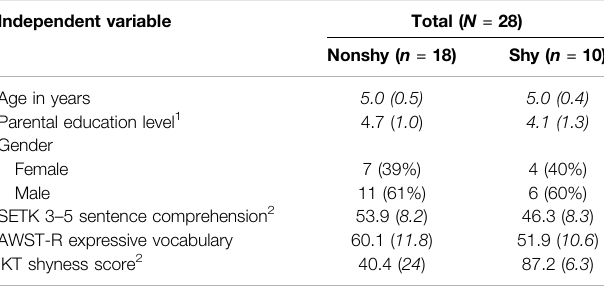
TABLE 1 | Mean participant characteristics for shy and nonshy children and standard deviation (SD). Independent